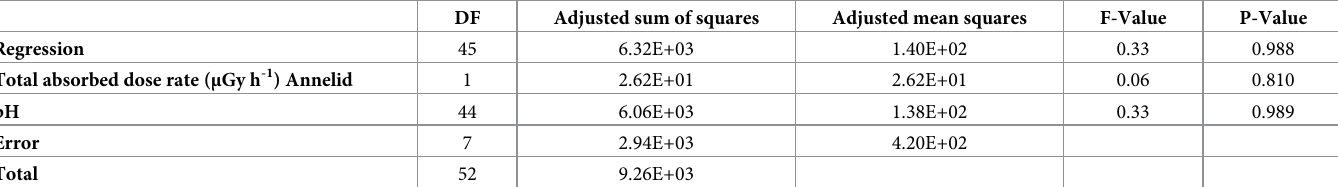
Table 5. Statistics of regression for